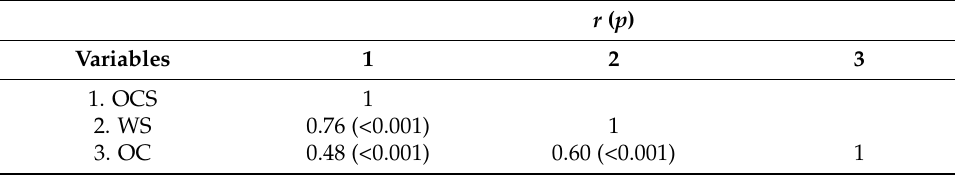
Table 2. Correlation between OCS, work satisfaction, and organizational commitment.